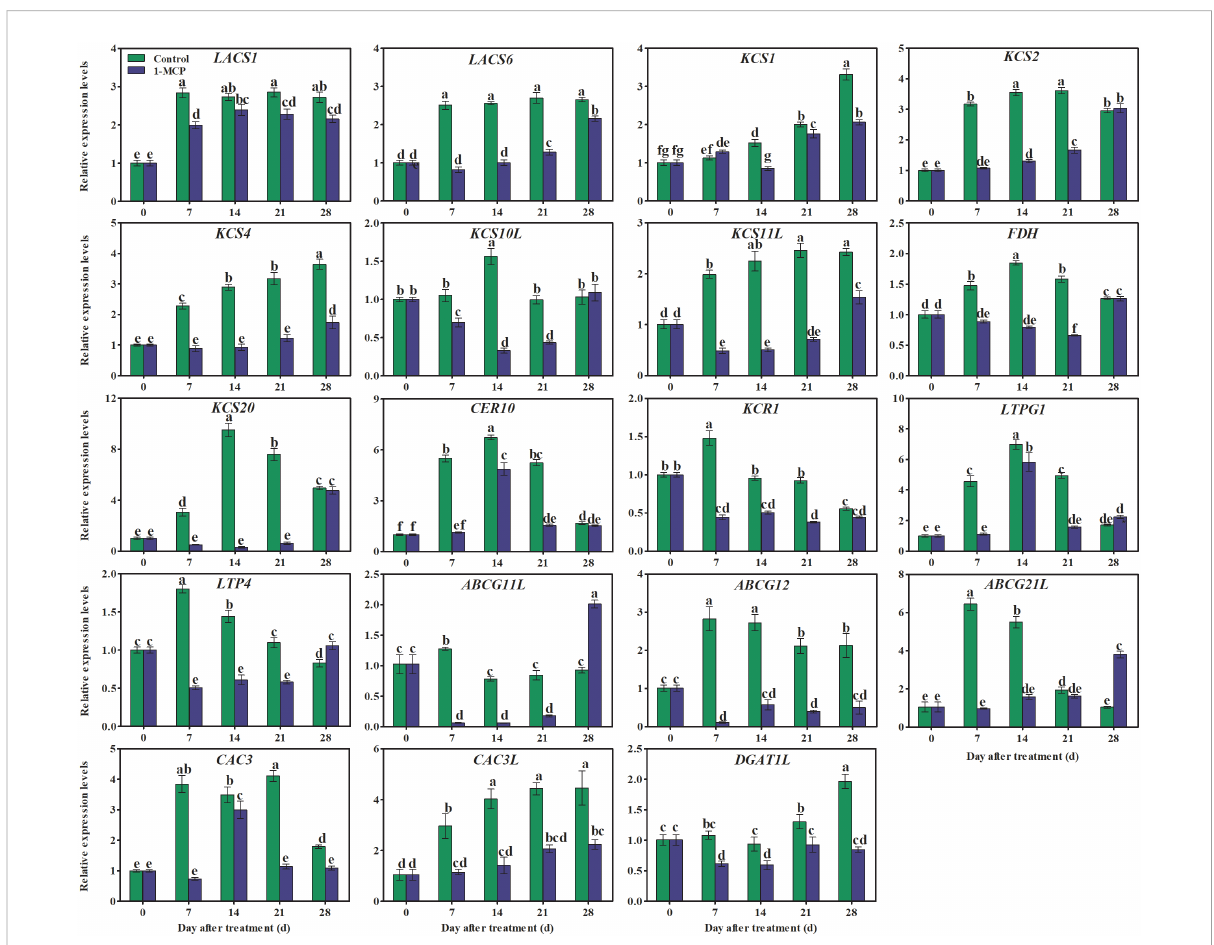
FIGURE 8 Effects of 1-MCP treatment on the expression pattern of genes associated with wax synthesis and transporter proteins in the peel of ‘ Yuluxiang ’ pear during storage. Data are mean ± SE ( n = 3); values labeled with different letters represent a signi fi cant difference at p